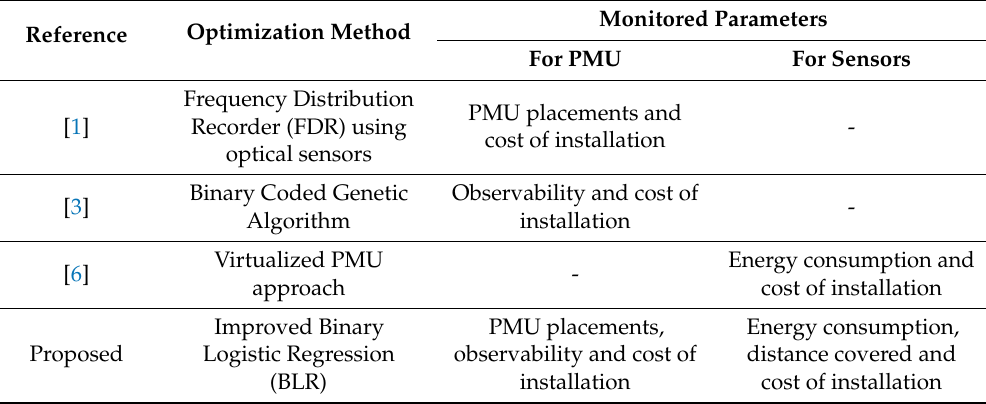
Table 1. Significant contributions associated with the proposed